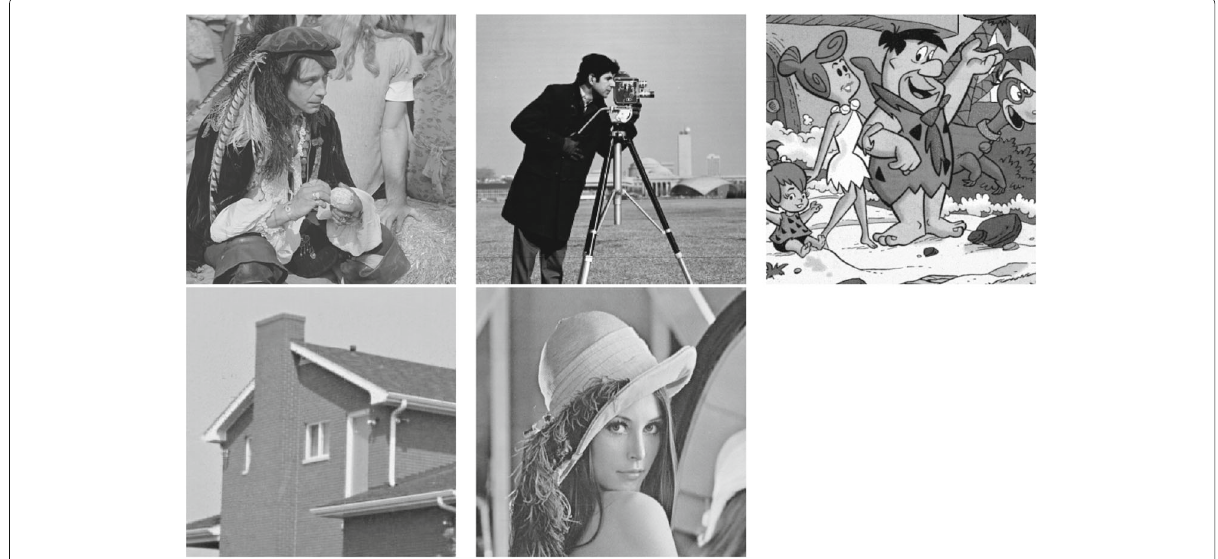
Fig. 1 Benchmark of images. Set of images used in the tests. This is a set of benchmark used as an original image in the